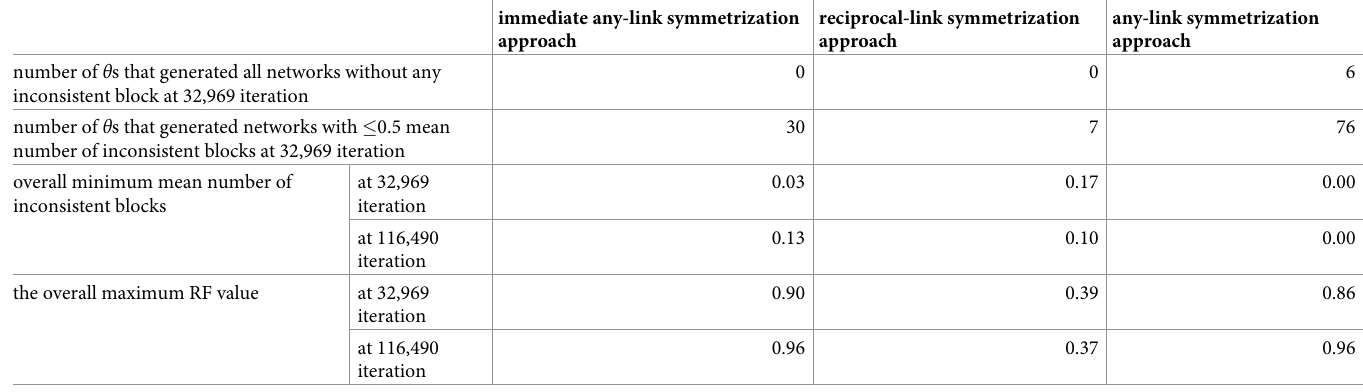
Table 3. The number of selected θ s (out of 300 randomly generated θ s) according to different selection criteria, the minimum mean IB and the maximum RF for dif- ferent approaches to generating networks.